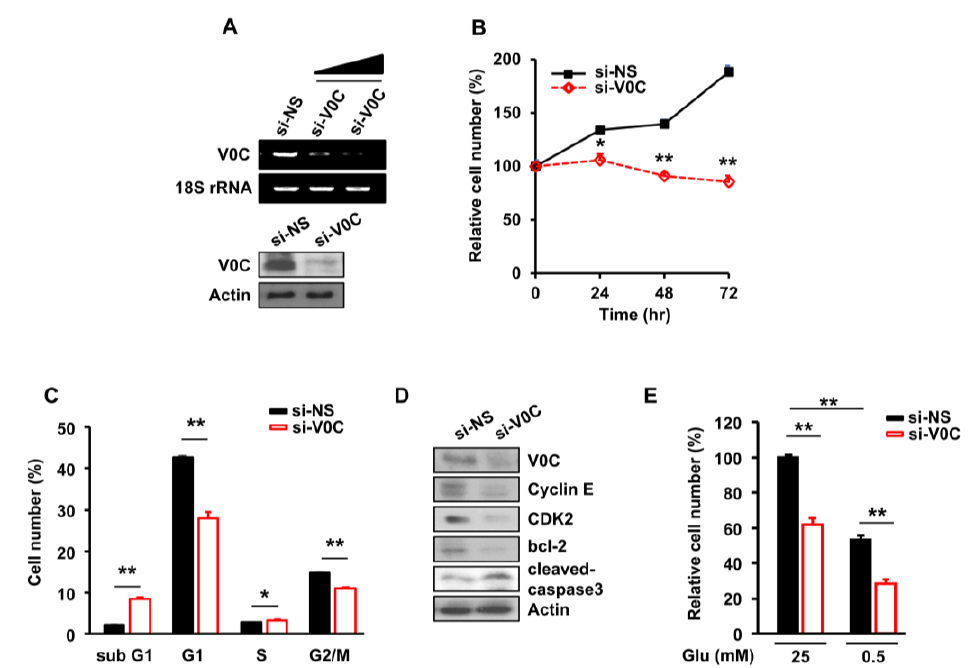
Figure 1. The vacuolar H + -adenosine triphosphatase (ATPase) subunit V0C (ATP6V0C) is crucial for esophageal cancer cell (ECC) proliferation in the presence of glucose. The TE8 cells were transfected with non-silencing siRNA (NS) or si-V1E1 for 72 h. ( A ) Whole-cell lysates from ATP6V0C-depleted TE8 cells were evaluated for ATP6V0C expression using RT-PCR or Western blotting. ( B ) Cell viability was analyzed using a trypan blue assay. ( C ) Cell cycle analysis was performed using flow cytometry. ( D ) TE8 cell lysates were analyzed with the indicated antibodies using Western blotting. ( E ) With high- (25 mM) or low- (0.5 mM) glucose conditions, the cell number was analyzed using a trypan blue assay. ( B – E ) Each data point is the average of three independent measurements. Values are mean ± SEM. (In ( B ), ANOVA; in ( C , E ), Student’s t -test; * p < 0.05; ** p < 0.01).